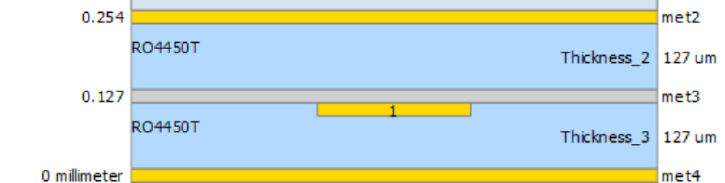
Figure 7. ADS controlled impedance line designer setup for obtaining stripline dimensions.